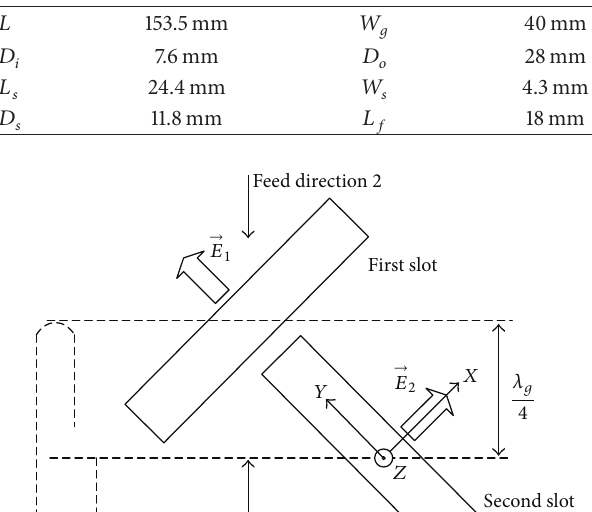
Table 1: Optimized geometric parameters of the omnidirectional CP antenna.